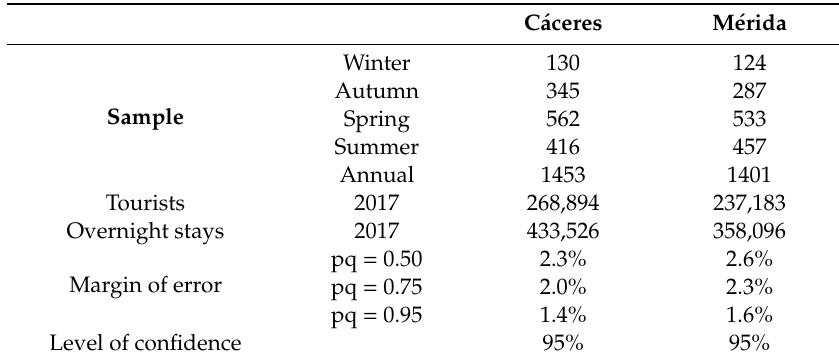
Table 1. Technical specifications of the